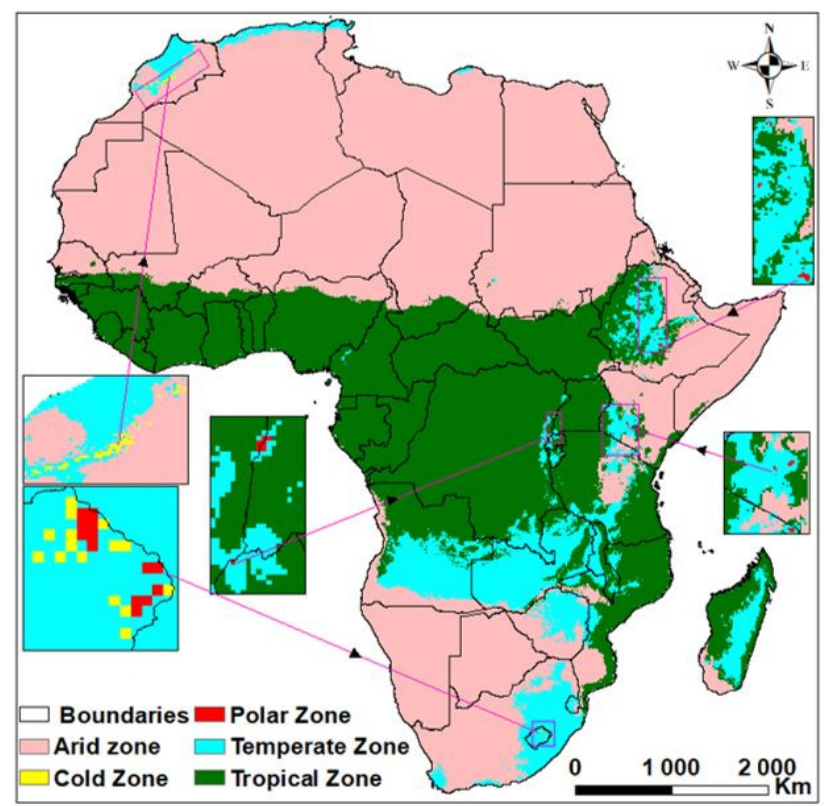
Figure 1. Five climate zones of Africa. This figure is a new figure reusing only some data from